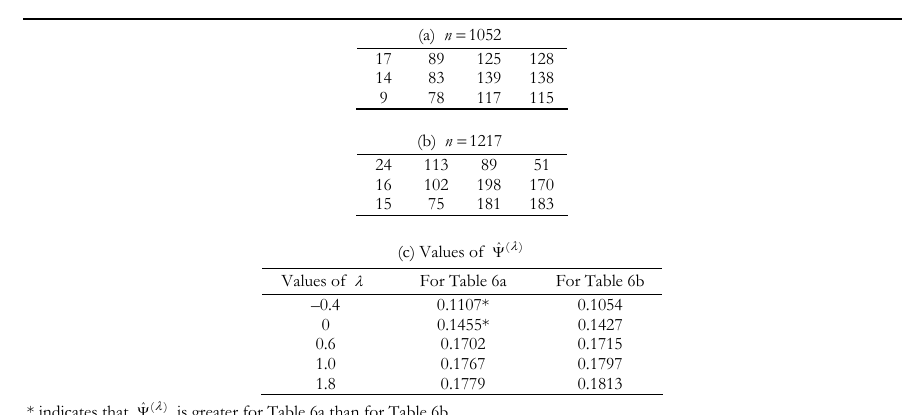
(a), (b) Artificial data ( n is sample size) and (c) corresponding values